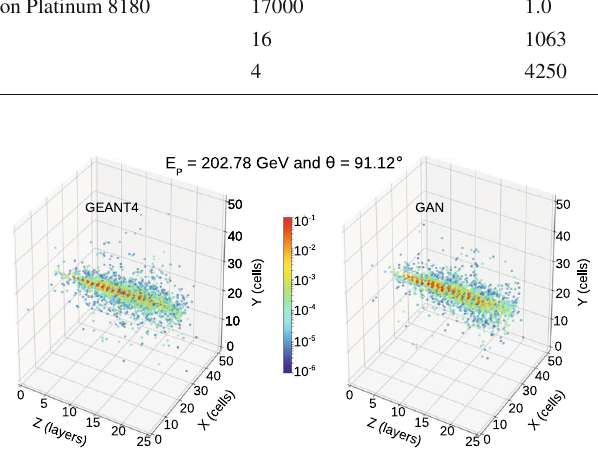
Fig. 6 Exampleofarandom GEANT4electronevent (left)with E P = 202 . 78 GeV and θ = 91 . 12 ◦ vs. an event generated by GAN (right) for the same E P and θ